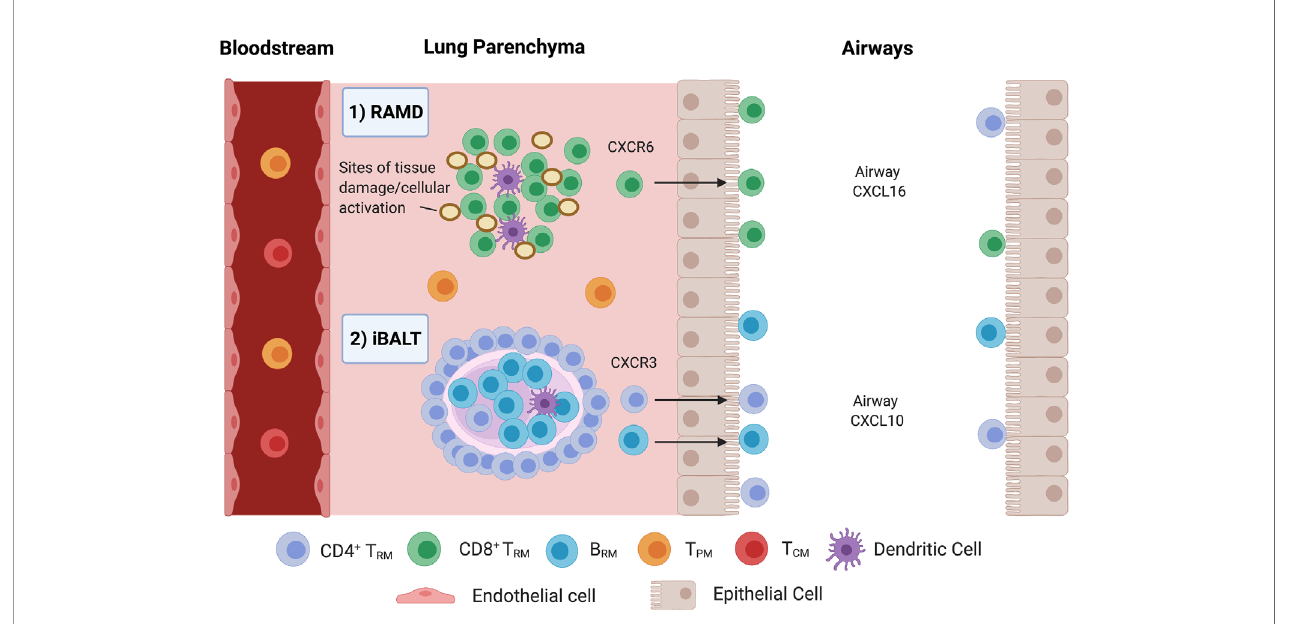
FIGURE 2 | Compartmentalisation of Pulmonary T RM and B RM . 1) CD8 + T RM are maintained in repair-associated memory depots (RAMDs) located in peribronchiolar foci in areas previously damaged from primary infection. RAMDs can be identi fi ed via the presence of cytokeratin-expressing cell aggregates which contain distal airway stem cells that help reconstruct damaged lung tissue (10). Murine evidence suggests interstitial CD8 + T RM are primarily maintained by a process of homeostatic proliferation and seed airway T RM , driven by CXCR6 in response to airway CXCL16 (38). 2) CD4 + T RM surround B RM cell follicles in iBALT located within the pulmonary parenchyma, where prolonged antigen persistence enhances CD4 + T RM /B RM formation. Just like RAMDs, iBALT requires tissue damage/in fl ammation for their establishment. CD4 + T RM are then recruited to the alveolar space via